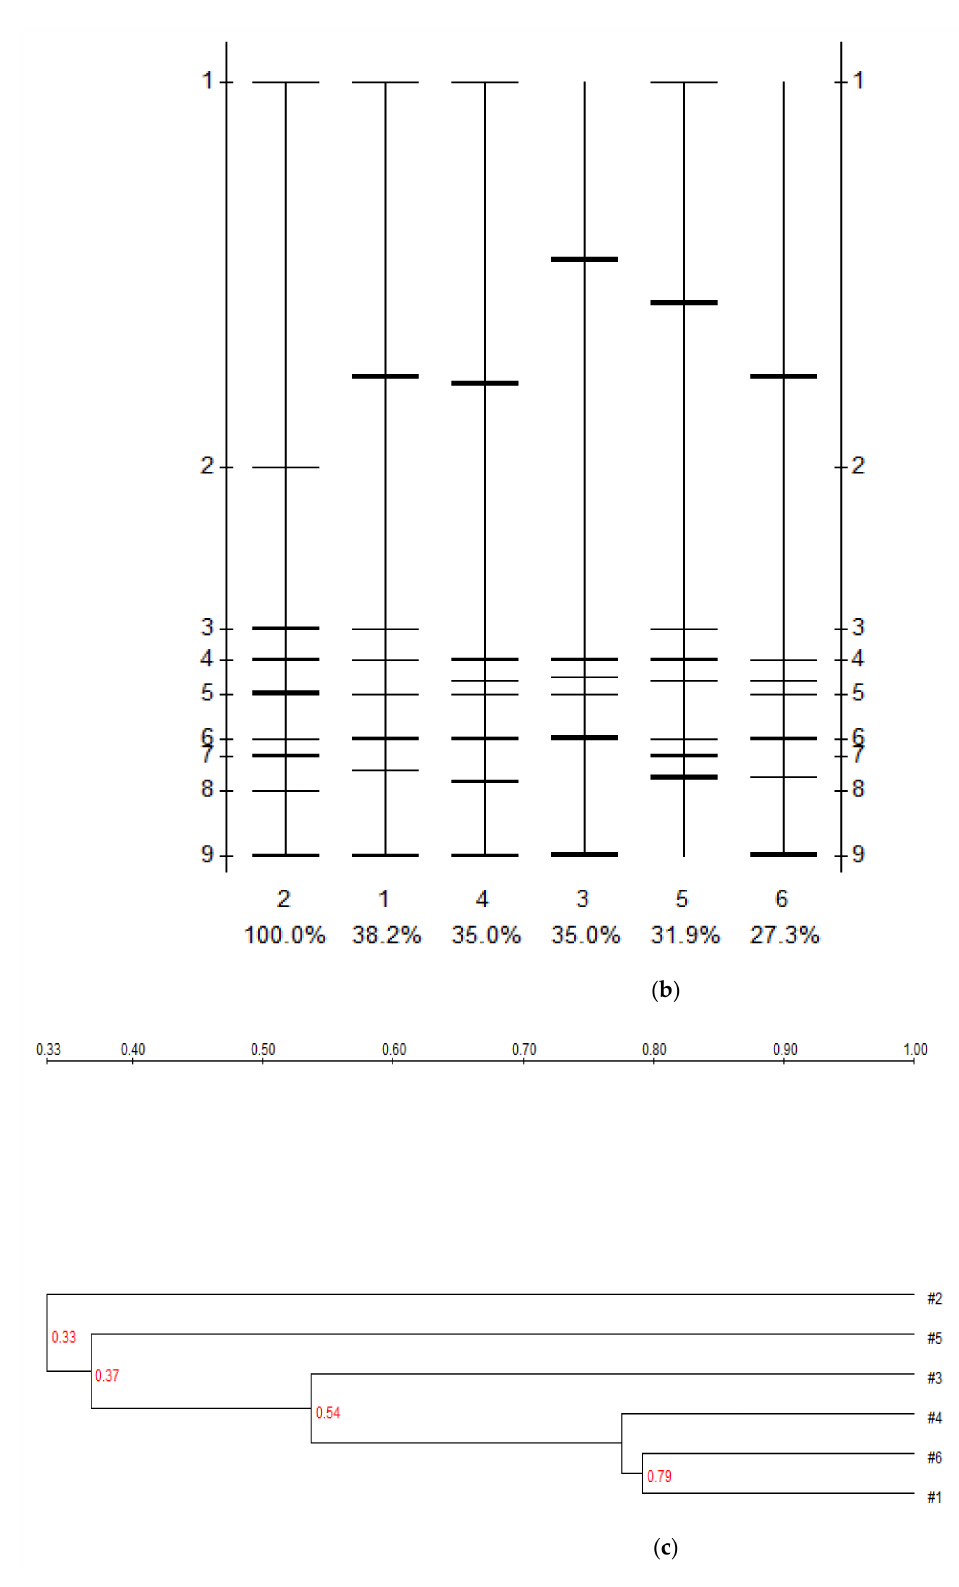
Figure 5. Fingerprint of DGGE and analyzed result in the soil with six treatments on the 90th day. ( a ) DNA electrophoresis fingerprint of DGGE; ( b ) diagram of compare lane images; ( c ) UPGAMA of phylogenetic tree. 90-1~90-6: S + G + D + B-90, S + G + D-90, S + G-90, S + D + B-90, S + D-90,